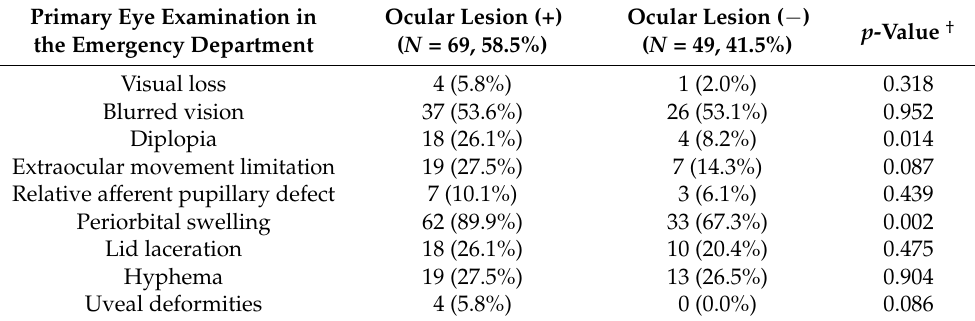
Table 2. Results of primary eye examinations in the emergency department in blunt head injury patients and comparisons between patients with and without positive ophthalmic lesions ( N =